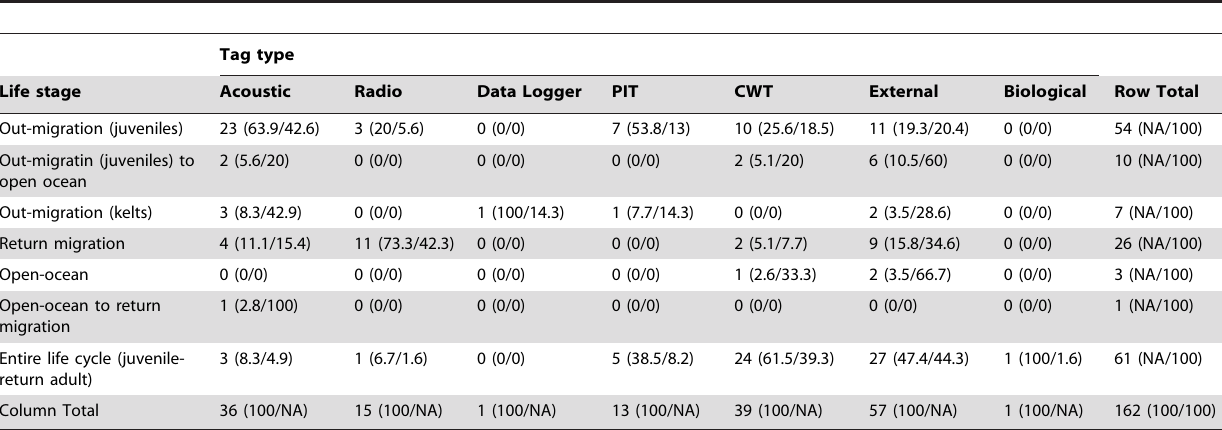
Table 1. Frequency (% within parentheses) of use of different tag types to study the life stages of anadromous salmonids in the marine environment for studies focusing on survival (i.e. those focusing on only survival and both on survival and behaviour).